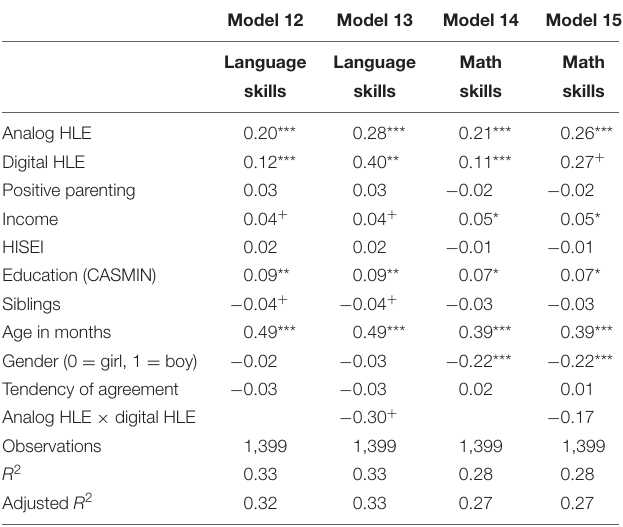
TABLE 8 | Multivariate regressions: associations between preschooler’s academic outcomes and digital and analog HLEs.